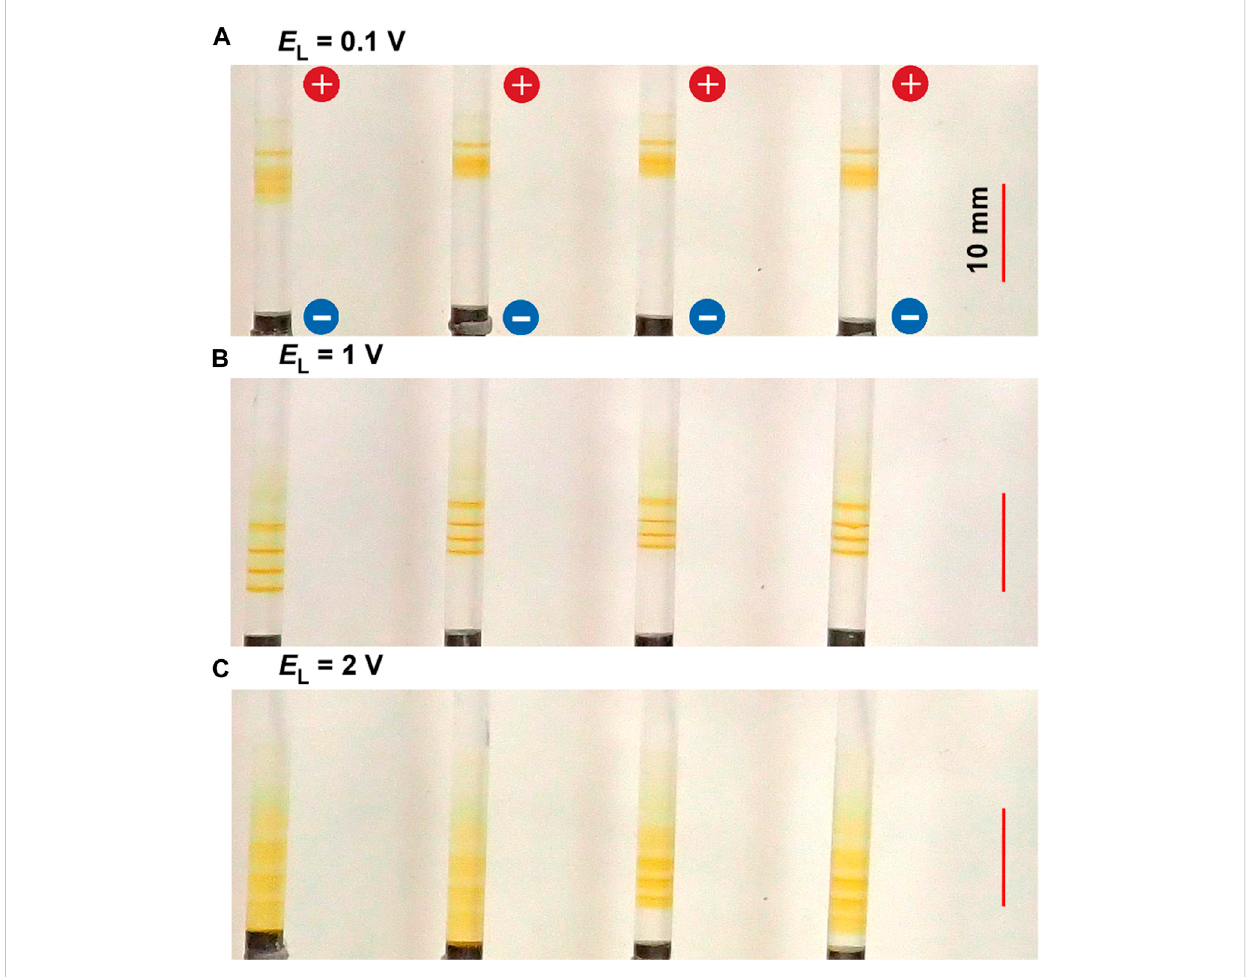
FIGURE 5 Typical periodic bands formed in the four gel columns with L = 50 mm at 25 ° C under the E L values (A) 0.1 (B) 1, and (C) 2 V. Here, E H = 3 V, T H = 1 h, T N L = 4 h, and C = 6 are kept constant. The scale bars are provided on the right parts of the images, and the charges of the electrodes are provided in the top